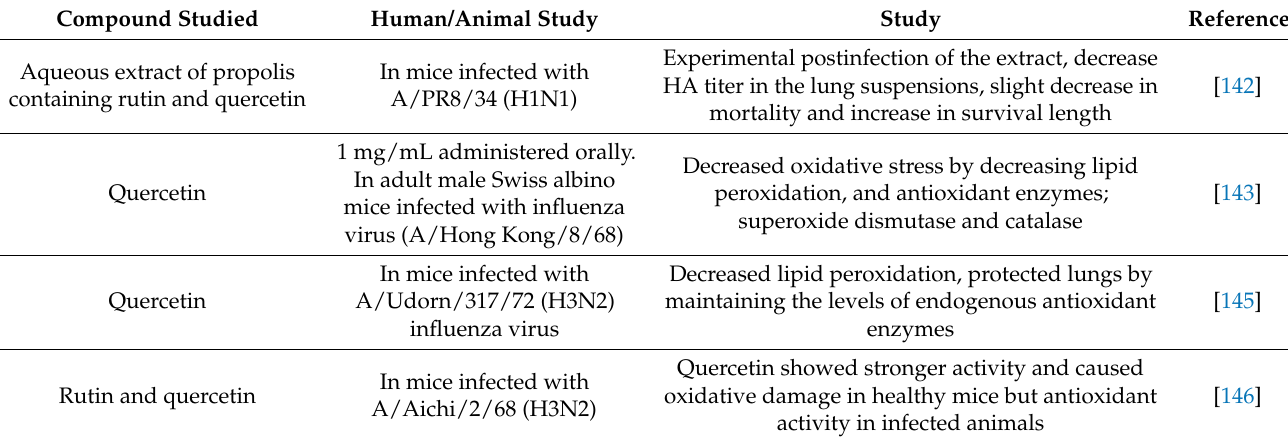
Table 2. Animal model and human studies of quercetin and